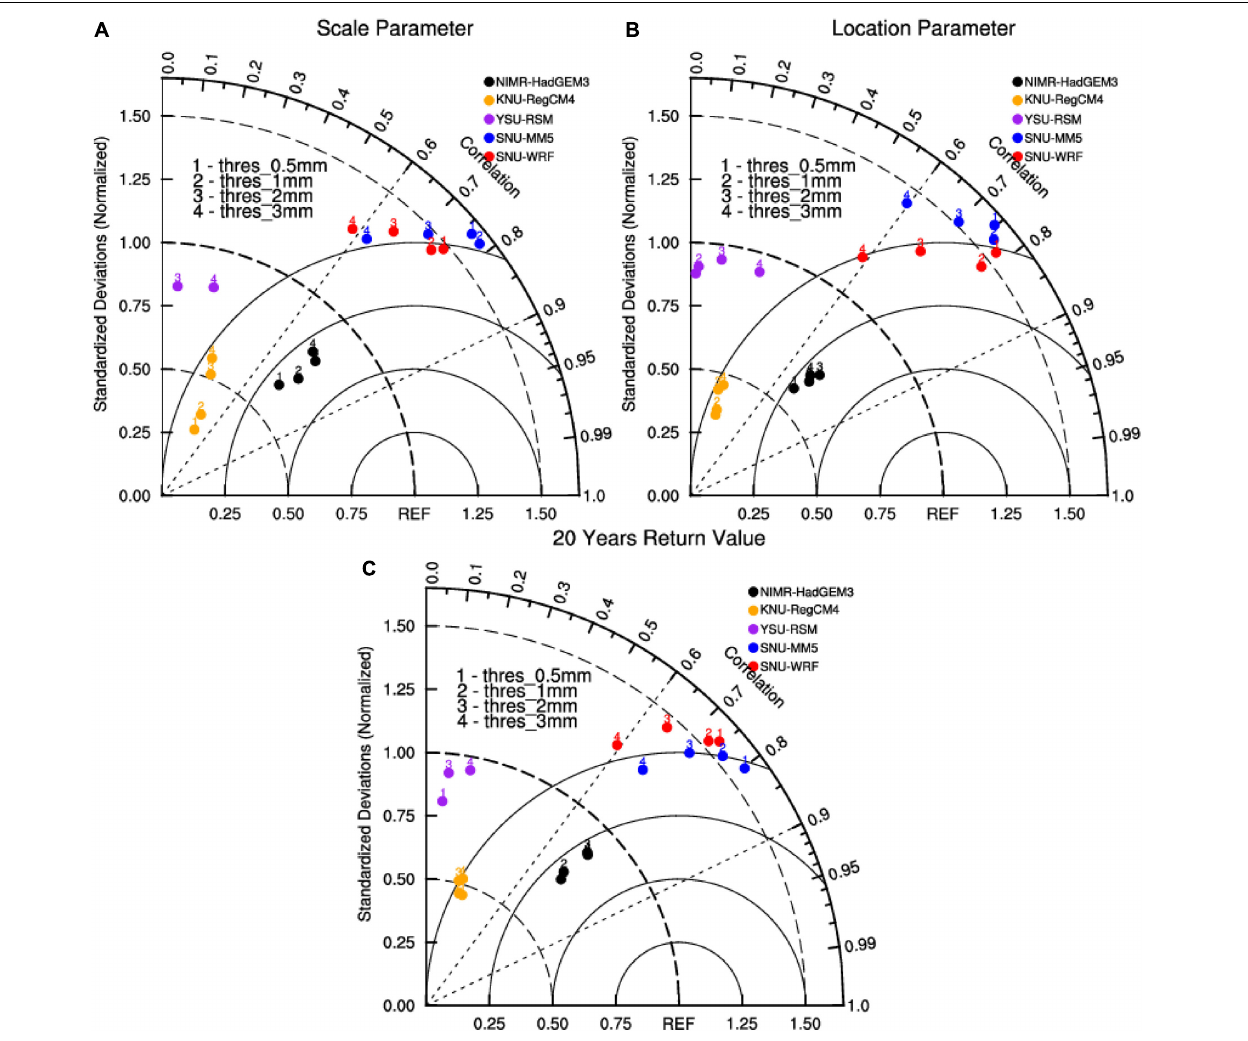
FIGURE 11 | Multivariable Taylor diagram displaying normalized statistical comparisons of the SNU-WRF (red), SNU-MM5 (blue), YSU-RSM (purple), KNU-RegCM4 (orange), and NIMR-HadGEM3 (black) simulated GEV (A) scale parameter, (B) location parameter, and (C) 20-year return value of the AMDSL, respectively. Numbers indicate four different thresholds for dry